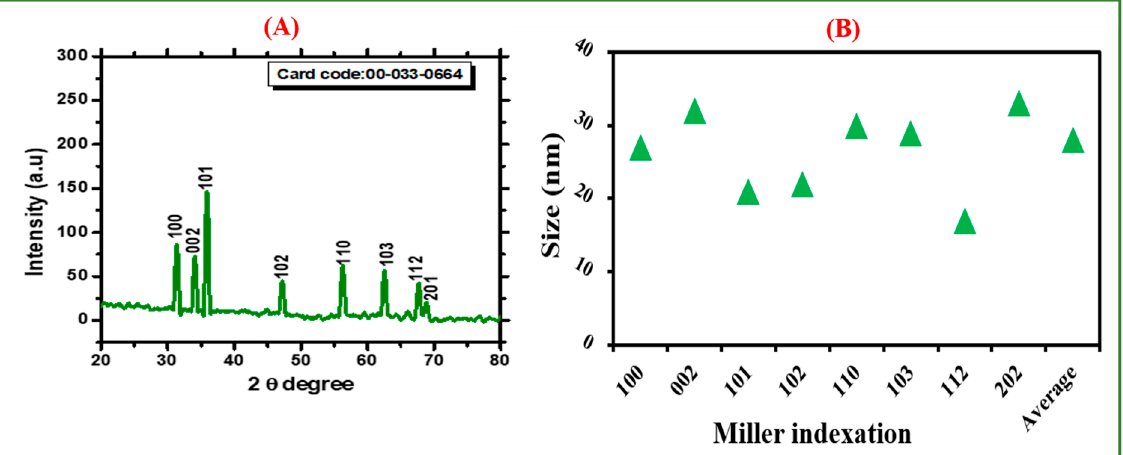
Figure 4. XRD pattern for biosynthesized zinc oxide NPs. ( A ) XRD pattern of Nostoc sp.-mediated zinc oxide; ( B ) size calculation using Debye–Scherrer equation.